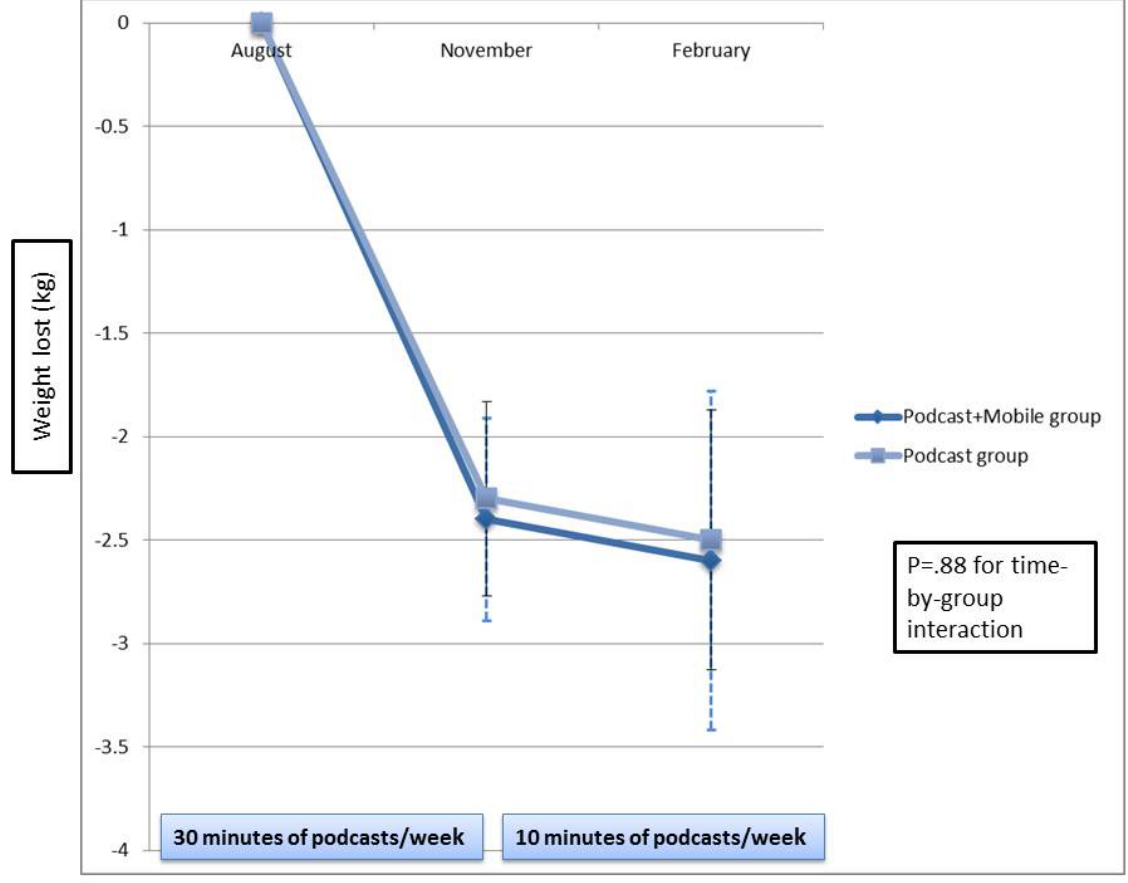
Figure 2. Weight (mean, SE) lost by group over 6